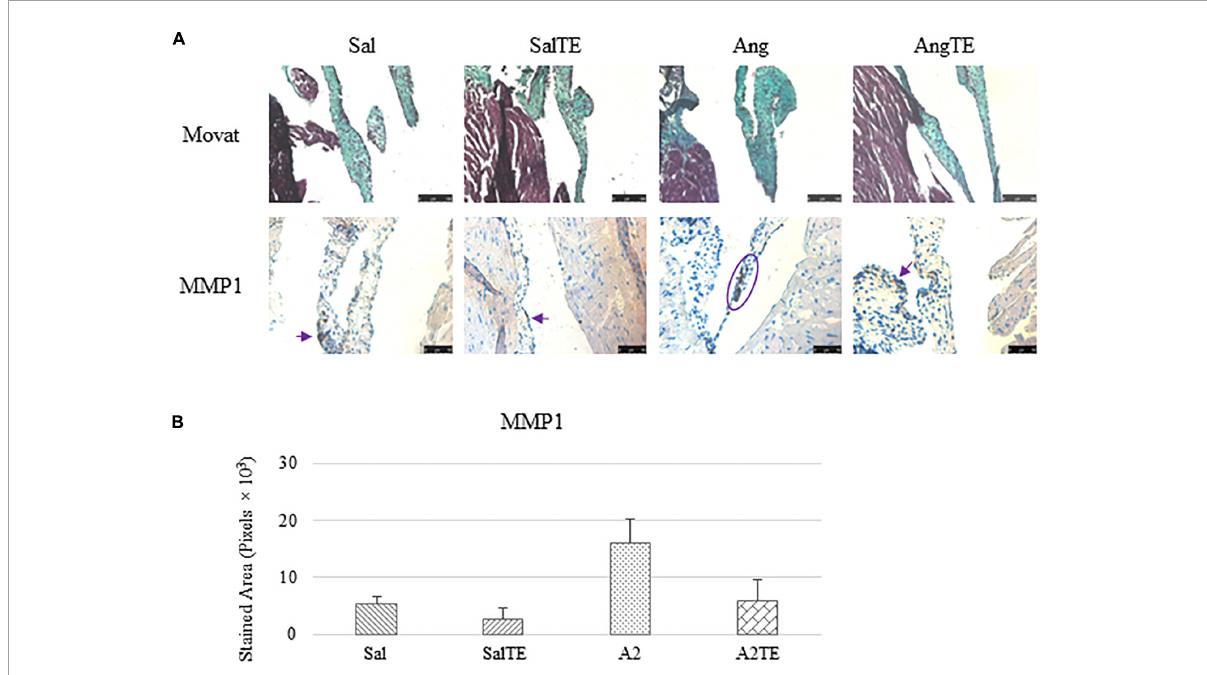
FIGURE8 (A) Investigation of mitral valve ECM remodeling by Movat stain and MMP1 IHC in reversal study. Major positive IHC stains were highlighted by circles and arrows. Scale bar on Movat images: 100 µ m. Scale bar on IHC images: 50 µ m. (B) Quantification of MMP1 expression was determined by total stained area in pixels that measured from 4 biological replicates in MATLAB. Asterisk indicates significant difference ( p < 0.05).